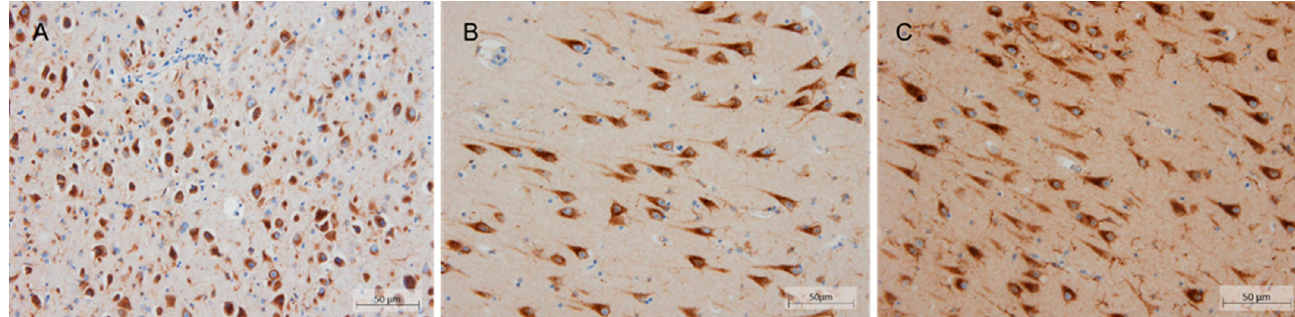
Figure 4. Post-mortem brain tissue from case 4. ( A ) Immunohistochemistry (IHC) staining of β -amyloid in parietal association cortex configuring amyloid plaques (20×). ( B ) Intense IHC staining of tau in the cortex of the middle temporal gyrus (20×). Scalebar: 100 μ m.